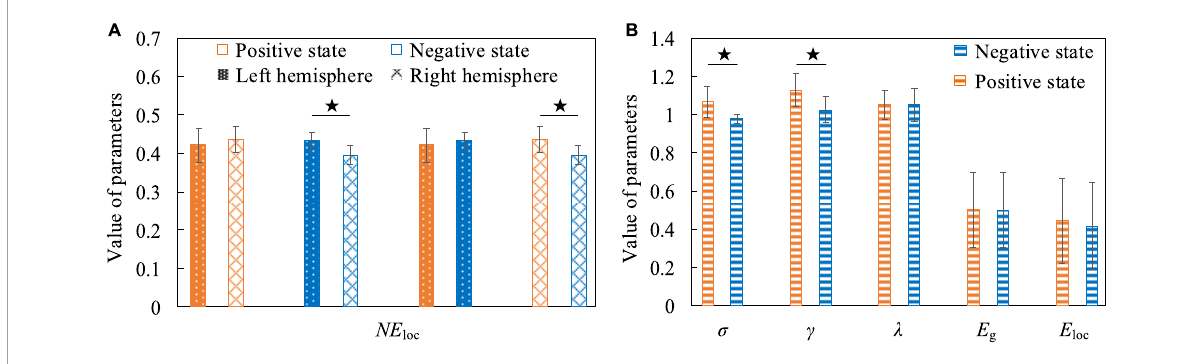
FIGURE12 The contrast histograms of five global attribute parameters and one local attribute parameter of the functional brain network during positive and negative states. (A) The NE loc in different situations when the electroencephalogram (EEG) is at low frequency. (B) Five global attribute parameters in two different states when the EEG is at high